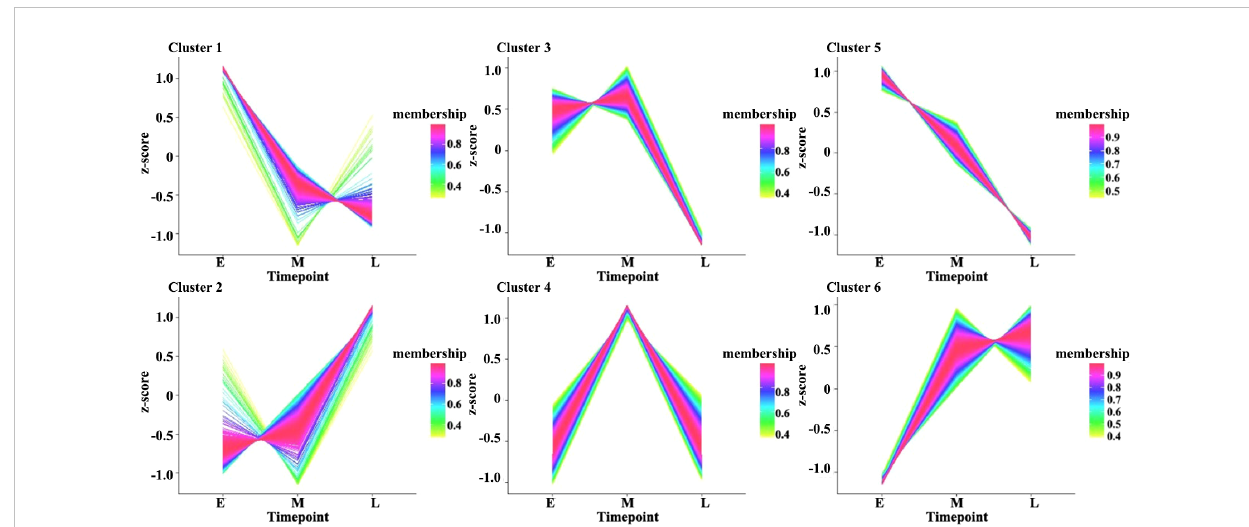
FIGURE 2 Clustered gene expression pro fi les in developing seeds. The clusters were de fi ned based on the temporal expression pro fi les of genes using K- means clustering in R. The Y-axis represents the standardized FPKM values of genes, and E, M, and L on the X-axis represent seed samples at 15, 30, and 50 DAP,